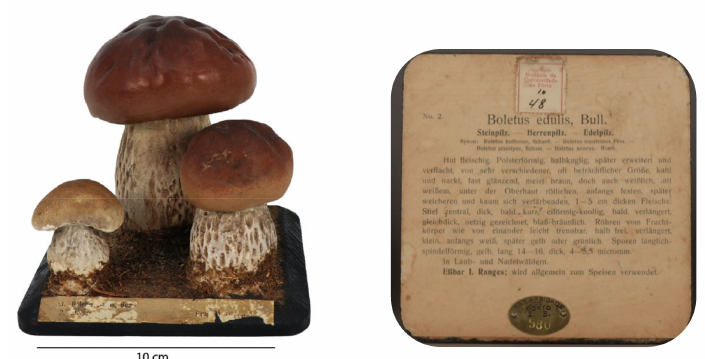
Figure 1. Model Boletus edulis, Bull. ( left image) and label glued on the base ( right image).